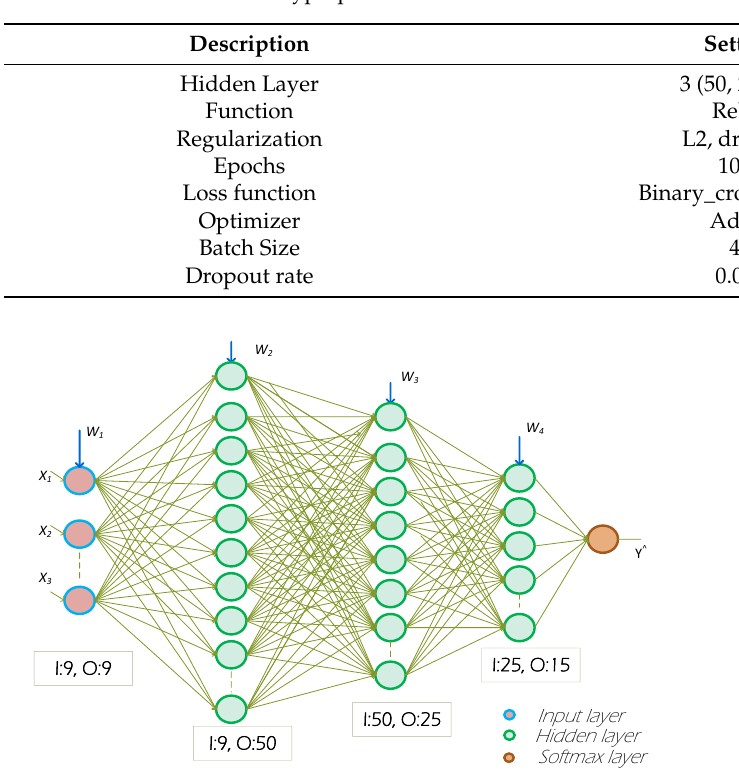
Table 5. DNN architectural hyperparameters.